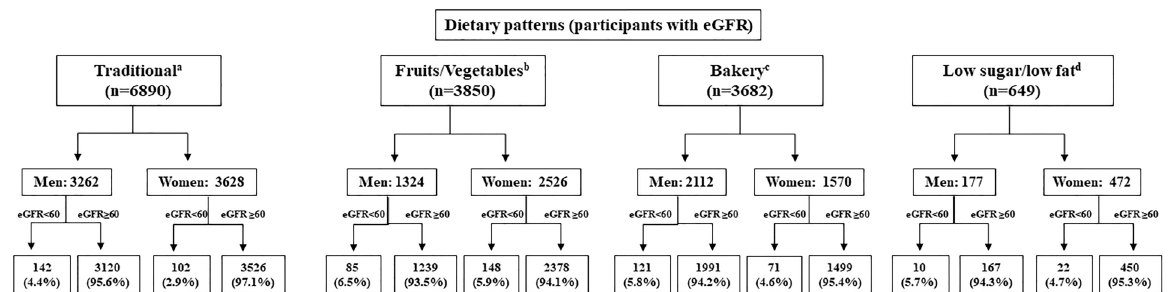
Figure 1. Distribution of dietary patterns according to estimated glomerular fi ltration rate (eGFR) in men and women. a P=0.0007, b P=0.52, c P=0.11, d P=0.68 (Fisher ’ s exact